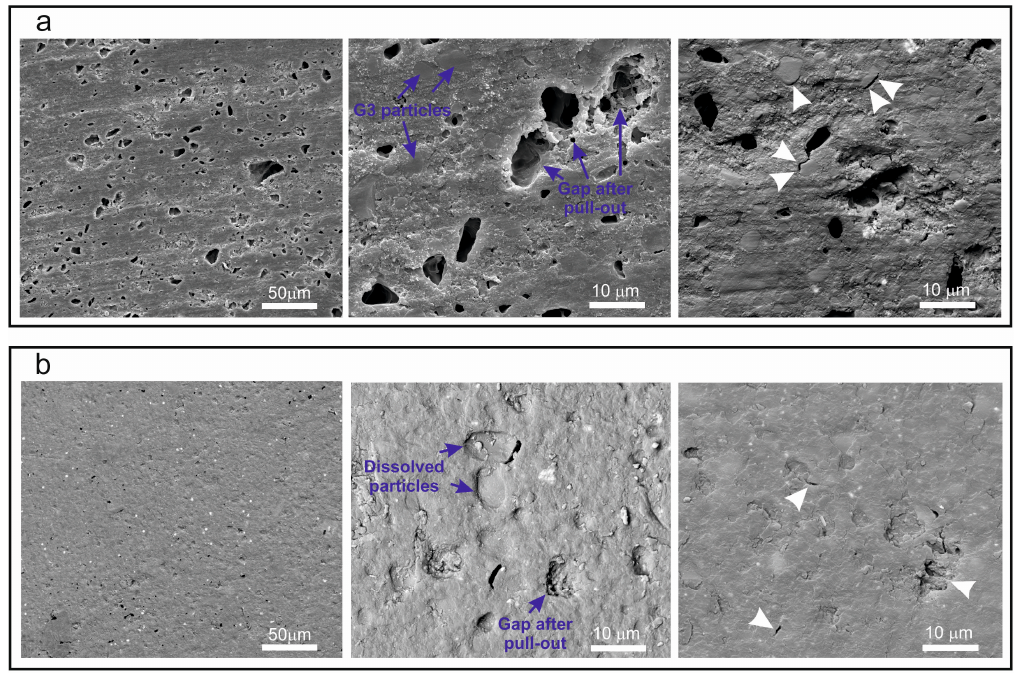
Figure 4. ( a ) Scanning electron micrographs at different magnifications of the G3-GC26 resin composite external surface; ( b ) Scanning electron micrographs at different magnifications of the 35ZnO-G26 resin composite external surface.